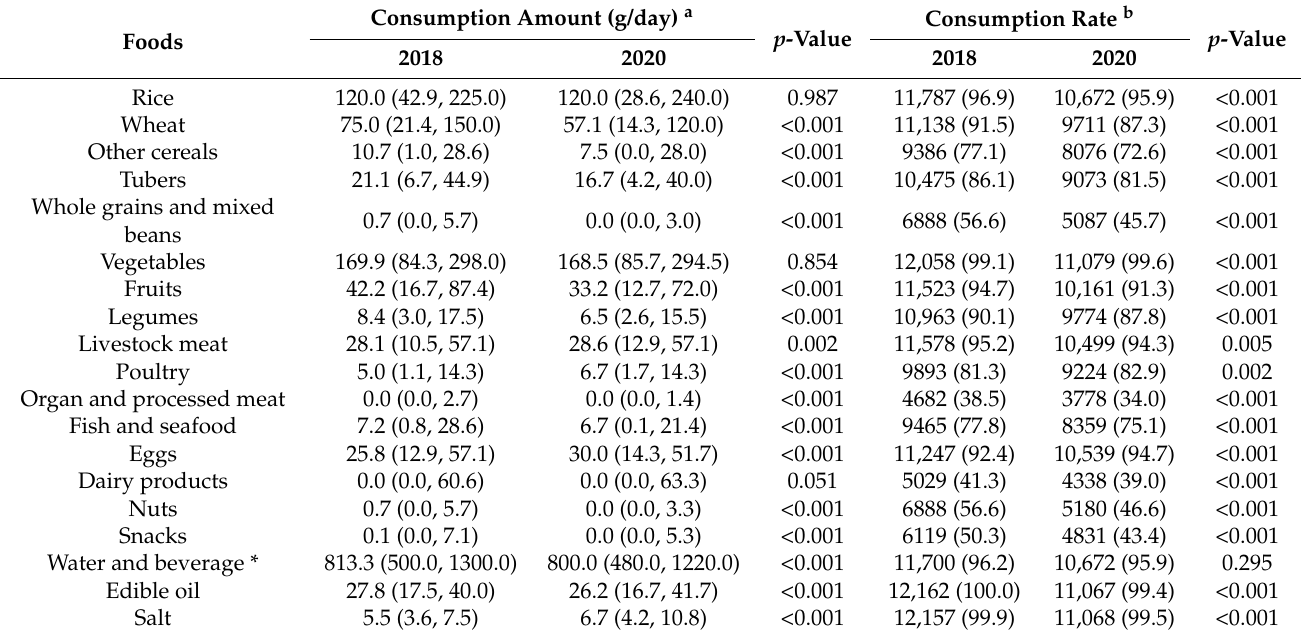
Table 1. Dietary Consumption Status of Chinese Adults Aged 55 Years and Above in Four Provinces in CCSNSD